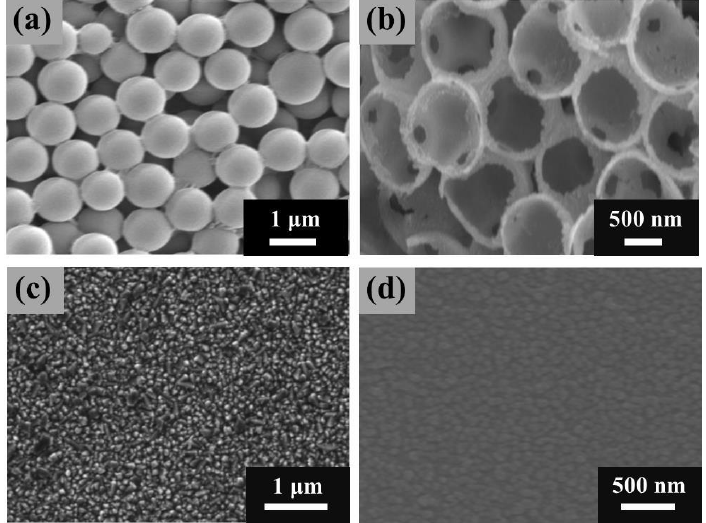
Figure 2. SEM images of the polystyrene microspheres (PS) template film ( a ), nanoporous NiS film ( b ), flat Pt/FTO ( c ), and flat NiS/FTO ( d ).